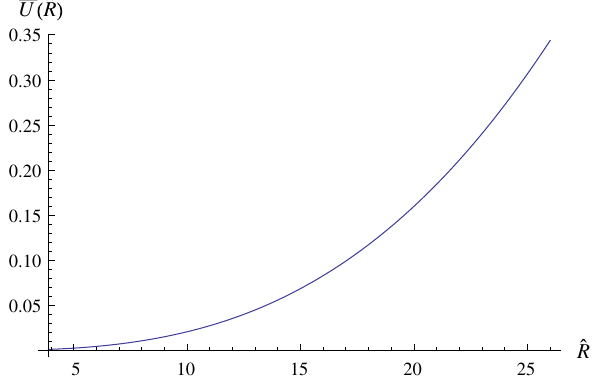
Fig. 8 Theevolutionof ¯ U ( ˆ R ) intheEinsteinframeinthecasewhenthe evolution of the universe starts from the generalized sudden singularity. For illustration it is assumed that f ( ˆ R ) = ˆ R + γ ˆ R 2 + δ ˆ R 3 , where (cid:3) (cid:4) (cid:3) (cid:4) s 2 Mpc 2 s 4 Mpc 4 γ = 10 − 9 and δ = 10 − 13 . ¯ U ( ˆ R ) is expressed in km 2 km 4 units of 10 4 km 2 s 2 Mpc 2